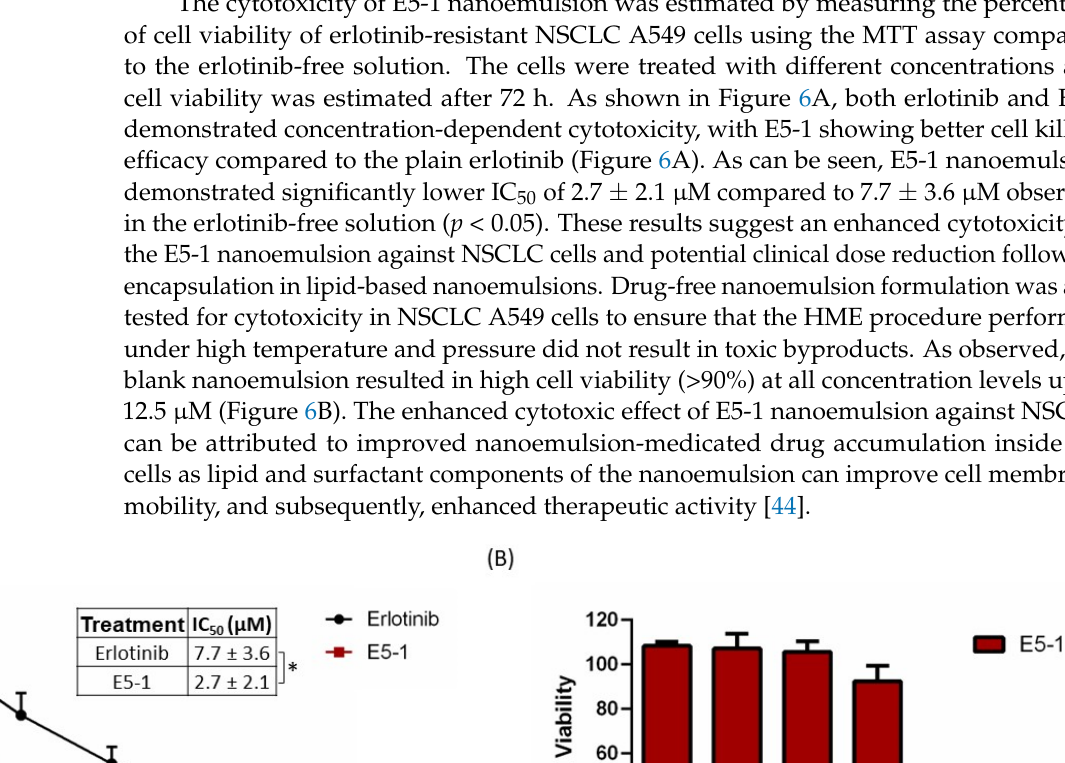
Figure 7. E ff ect of single-dose treatment on the growth of a 3D spheroid tumor of A549 cells. Sphe- roid images taken at day 0, 3, 9, and 15 post treatment were compared for single dose treatment